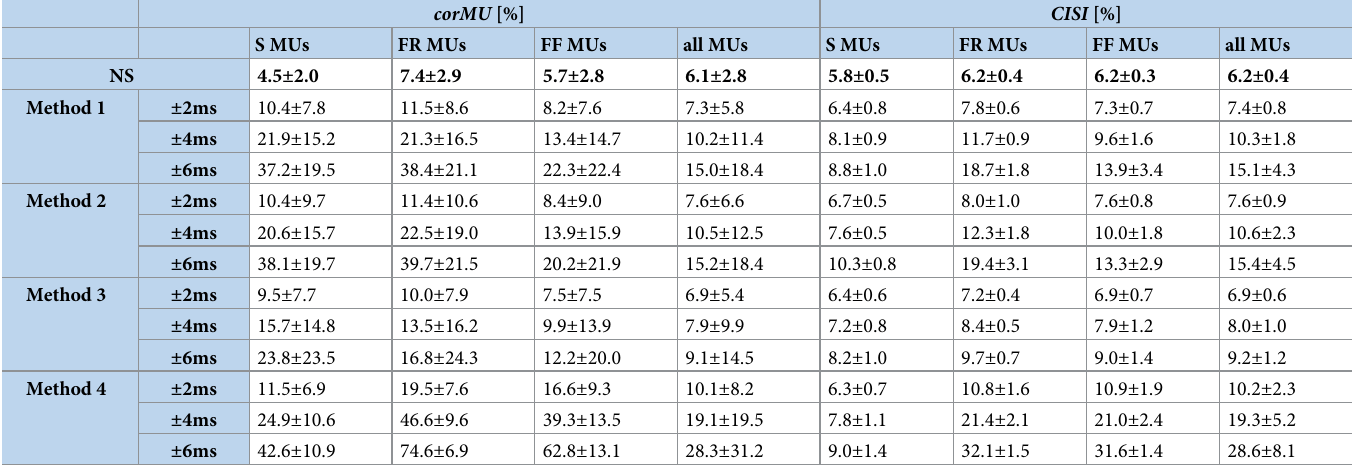
Table 2. Two indices of synchronization ( corMU and CISI ), measured for the NS model and four methods of synchronization (Methods 1–4) within three time win- dows ( ± 2, ± 4, and ± 6 ms). All values are reported as mean value ± standard deviation for different physiological types of MUs (S, FR, and FF) and for all MUs within the muscle.